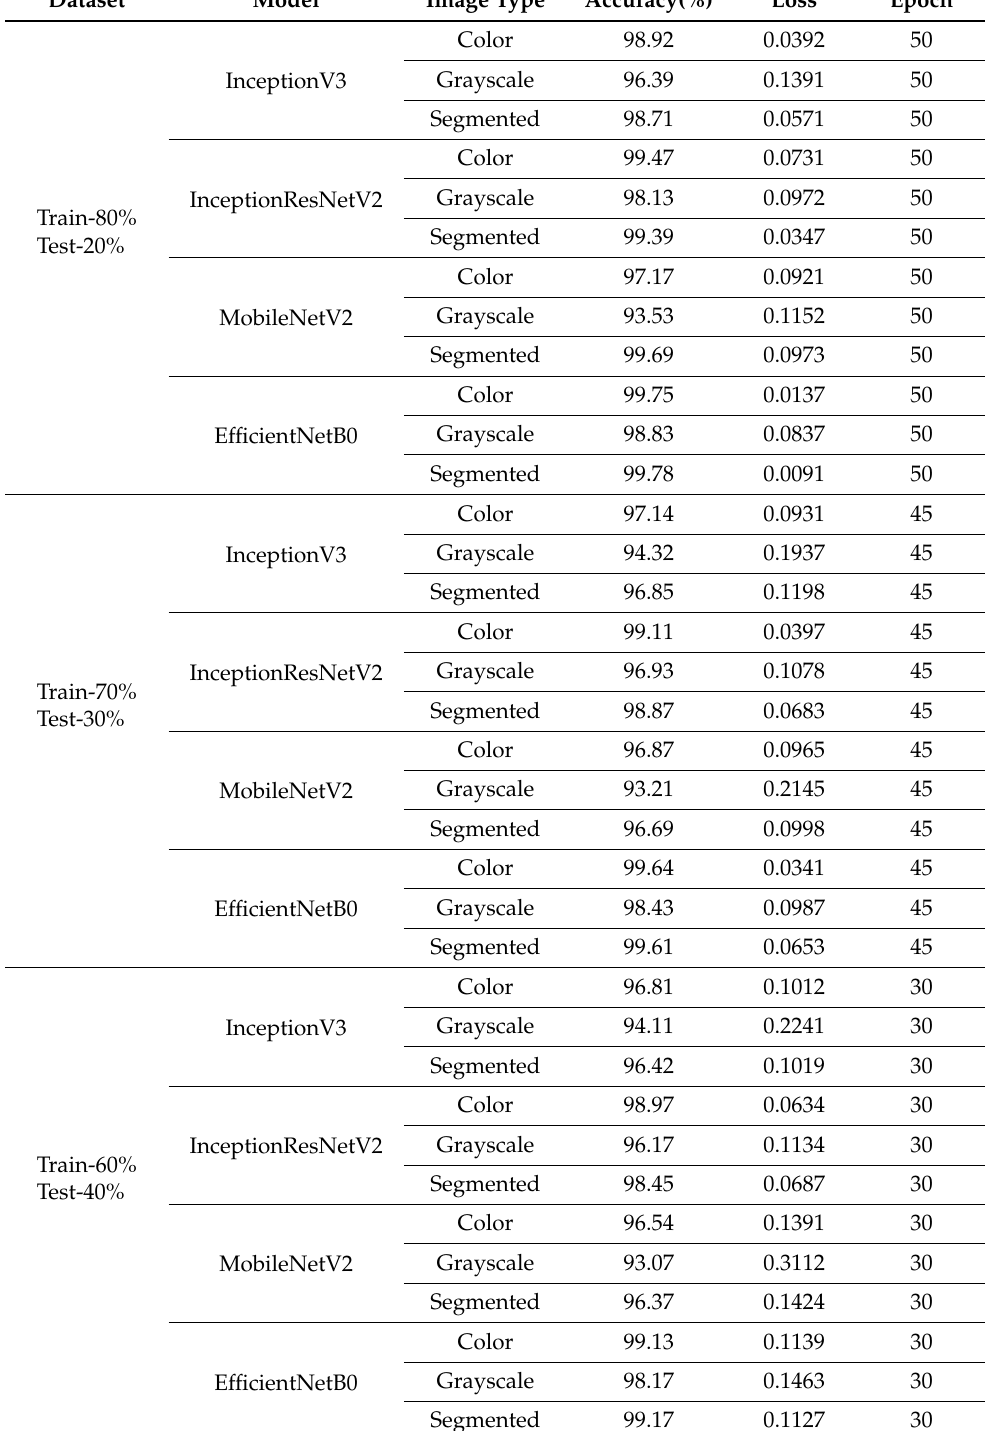
Table 9. Accuracy and loss of implemented models regarding different image types along with different train-test split